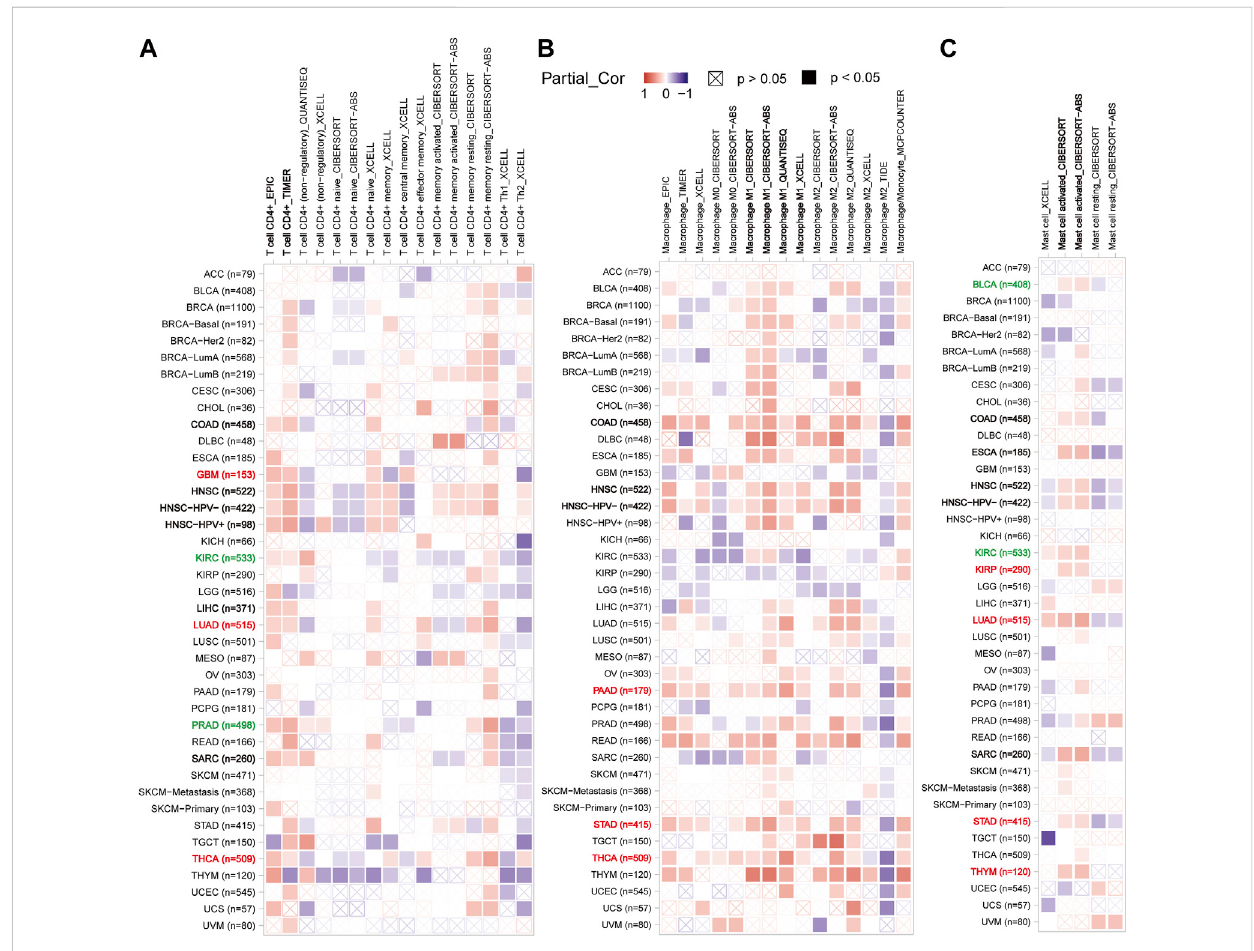
FIGURE 5 Correlation betweenCX3CL1expressionandthein fi ltrationlevelofimmunecellsinpan-cancer(TIMER2). (A) Thecorrelationheatmapdepictedthe correlationbetweenCX3CL1geneexpressionandthein fi ltrationlevelsofCD4 + TcellsindistinctcancertypesutilizingEPIC,TIMER,QUANTISEQ,XCELL, CIBERSORT, and CIBERSORT-ABS methods. (B) The correlation heatmap depicted the correlation between CX3CL1 gene expression and the in fi ltration levels of macrophage in distinct cancer types utilizing EPIC, TIMER, XCELL, CIBERSORT, CIBERSORT-ABS, QUANTISEQ, TIDE, and MCPCOUNTER methods. (C) ThecorrelationheatmapdepictedthecorrelationbetweenCX3CL1geneexpressionandthein fi ltrationlevelsofmastcellsindistinctcancer types utilizing XCELL, CIBERSORT, and CIBERSORT-ABS